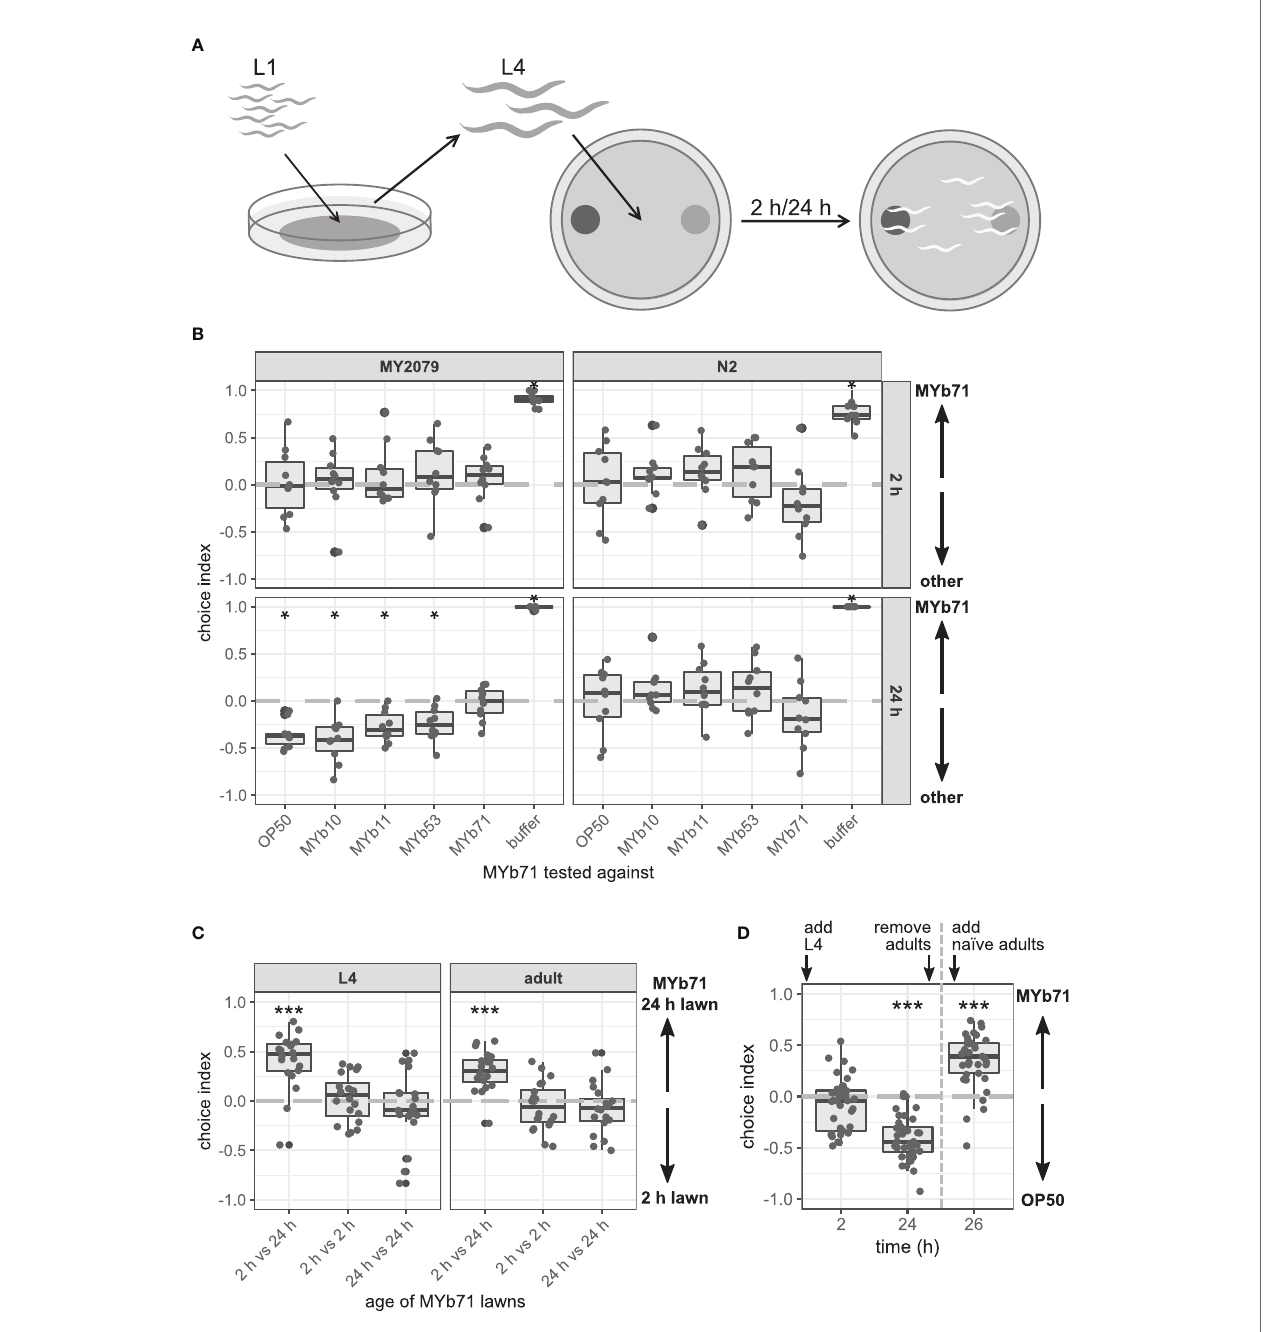
FIGURE 2 | The late microbiota avoidance response is speci fi c to MYb71, independent of MYb71 lawn age, and is not shown in naïve MY2079. (A) Synchronized Caenorhabditis elegans were grown on OP50 until L4 stage and then used in binary-choice experiments using MYb71 (dark gray) vs. a test bacterium (light gray). The choice index was determined at 2 and 24 h post L4. (B) The choice behavior of C. elegans N2 and MY2079 toward MYb71 was tested against individual microbiota isolates or OP50 (n = 10, with ~70 worms per n). (C) Choice behavior of MY2079 L4 larvae and adults toward a “ new ” (2 h) and “ old ” (24 h) lawn (n = 20, with ~70 worms per n). (D) MYb71 and OP50 on choice plates were exposed to MY2079 worms, and the choice behavior of MY2079 was evaluated after 2 and 24 h. After removal of the initially placed worms, the choice behavior of naïve adults was evaluated after 2 h on the same plates (n = 34-40, with ~70 worms per n). A negative choice index indicates a choice of (B) OP50, MYb10, MYb11, MYb53, or a buffer control; or (C) the 2 h lawn; or (D) OP50. A positive choice index indicates a choice of (B, D) MYb71 or (C) the 24 h MYb71 lawn. A choice index of 0 indicates the equal choice of bacteria on both sides. Wilcoxon signed-rank test (Wilcoxon, 1945) with false discovery rate (FDR) correction for multiple testing was applied for comparing the choice indices to 0. Data are presented in boxplots; each gray dot represents one replicate. Signi fi cance is designated to the following scale: *** p < 0.001, * p <